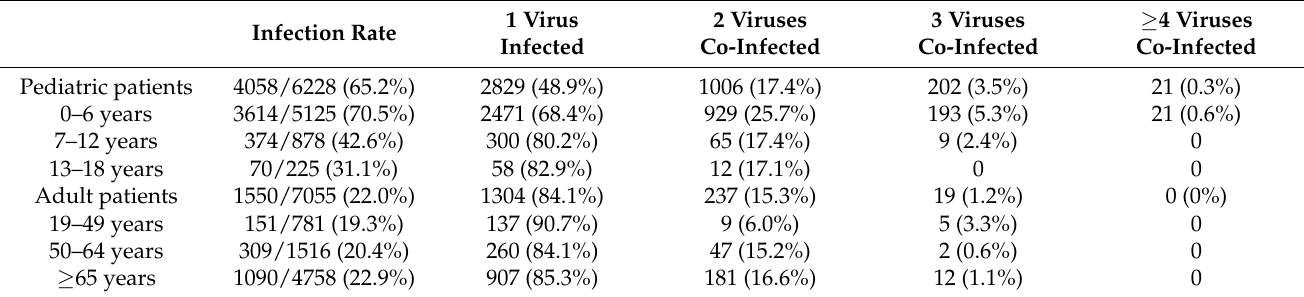
Table 3. Virus infection patterns (infection rate, co-infection